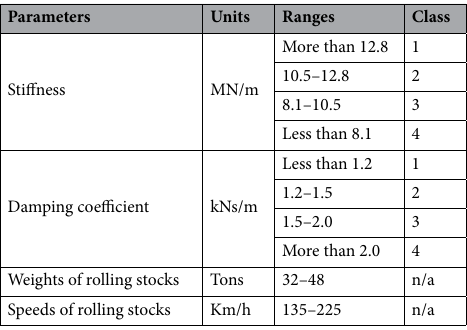
Table 1. Ballast stiffness and damping coefficient